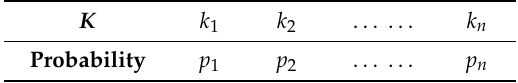
Table 1. The probability mass function of random variable K